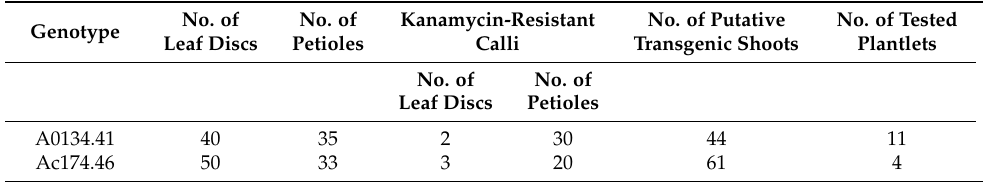
Figure 2. In vitro cultures (Ac174.46 genotype) after co-cultivation with Agrobacterium strains containing p DIRECT22C :gRNAs . ( A ) Kanamycin-resistant calli appeared along the cut petioles in 4–8 weeks. ( B ) Kanamycin-resistant adventitious buds regenerated from calli in 12–16 weeks. ( C ) Putative transgenic shoots ready for in vitro propagation on elongation medium before genetic analyses. Table 1. Summary of Actinidia transformation.